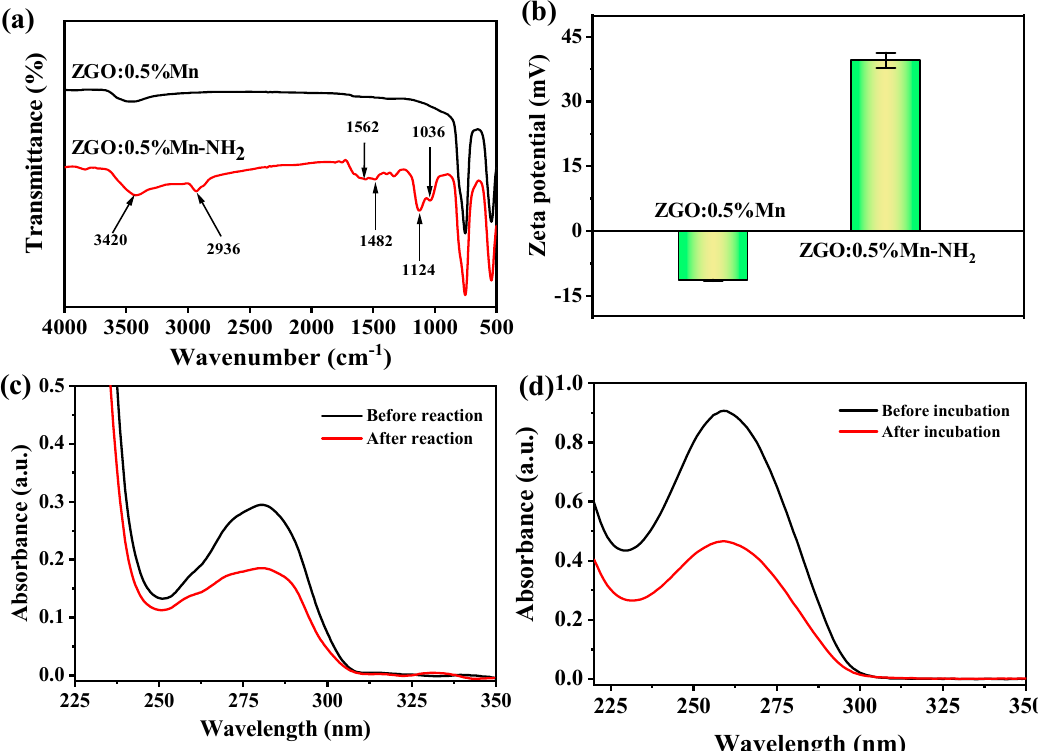
Figure 4. ( a ) FT-IR spectra of the ZGO:0.5%Mn before and after amination. ( b ) The change of Zeta potential before and after the amination treatment. ( c ) UV-vis spectra of the avidin solution before and after binding with ZGO:0.5%Mn-NH 2 . ( d ) UV-vis spectra of the biotin-labelled aptamer supernatant before and after incubation with ZGO:0.5%Mn-avidin.